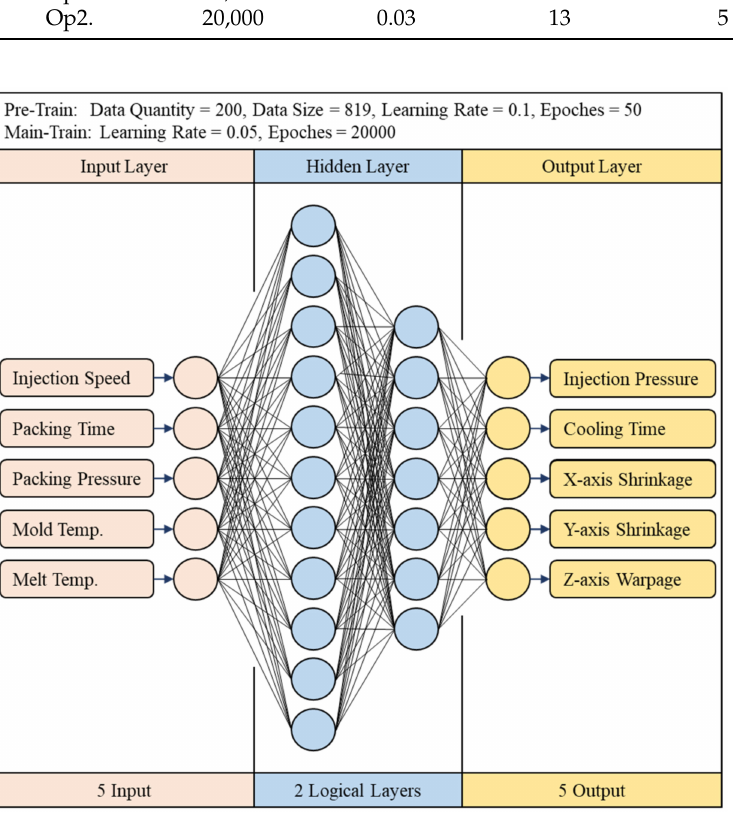
Figure 15. Optimal network architecture